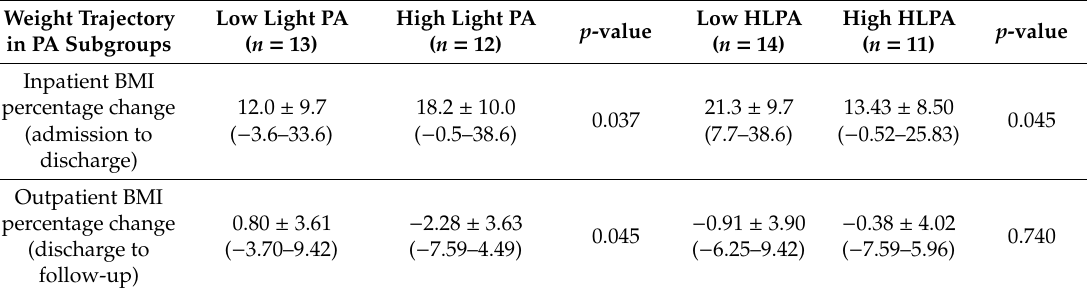
Table 3. Impact of light PA and high-level PA in anorexia nervosa patients at admission on BMI trajectory (BMI percentage change) from admission to discharge and from discharge to outpatient